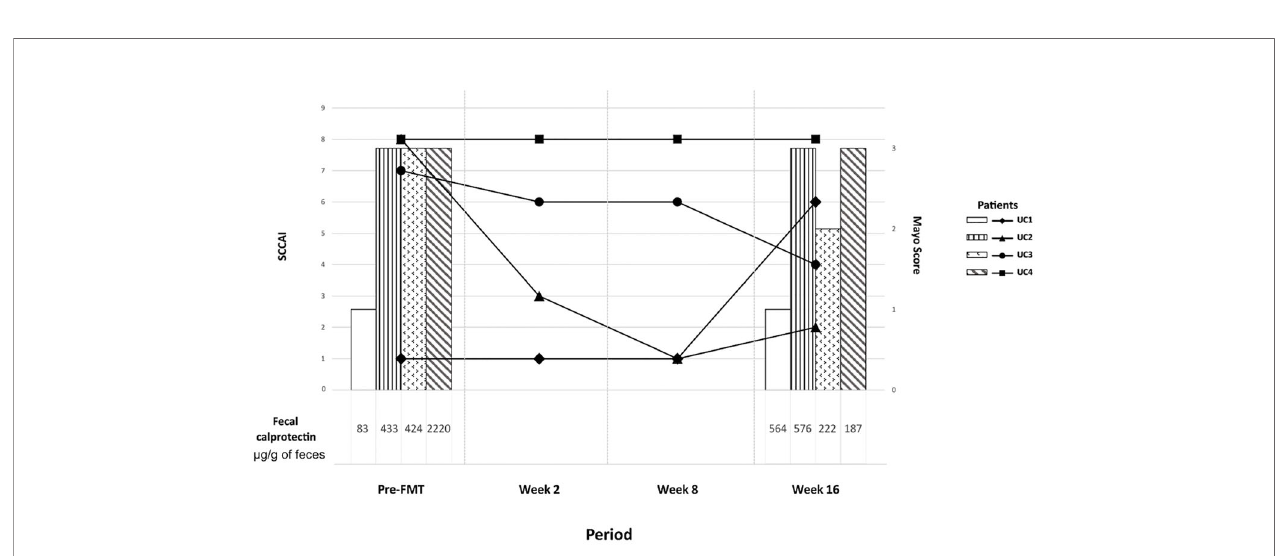
FIGURE 6 | Clinical evolution of the four patients with ulcerative colitis over time, from the moment before fecal microbiota transplantation (FMT) (left) to the end of the follow-up at week 16 (right). The solid lines represent the SCCAI value at each time, whereas the bars (only recorded before FMT and at week 16 after FMT) showed the Mayo endoscopic score. Finally, fecal calprotectin levels for each patient before FMT and at week 16 were showed under the X